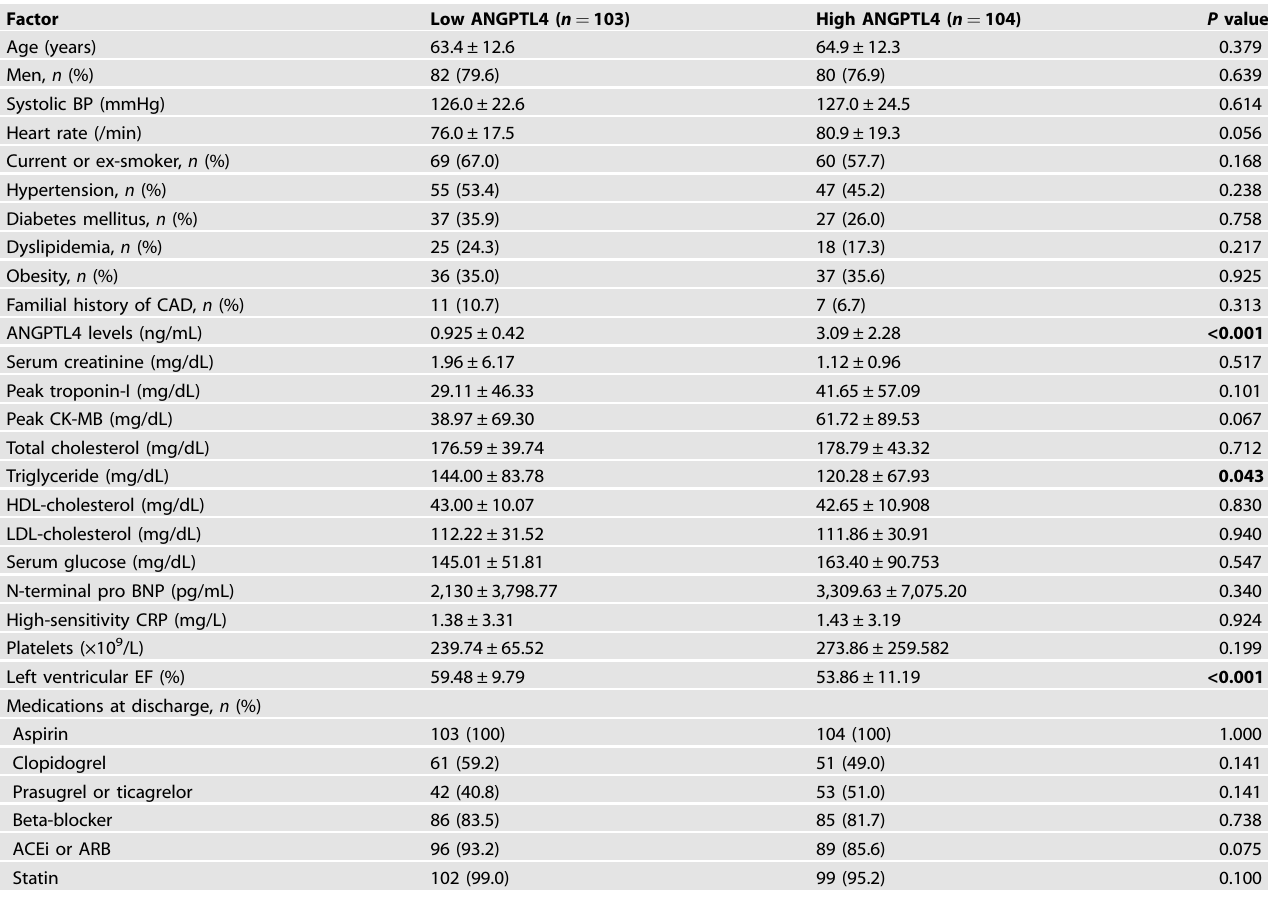
Values are presented as the mean ±SD or number (percentage). ACEi angiotensin-converting enzyme inhibitor, ARB angiotensin-II receptor blocker, BNP brain-type natriuretic peptide, BP blood pressure, CAD coronary artery disease, CK-MB creatine kinase-myocardial band isoenzyme, CRP C-reactive protein, EF ejection fraction, HDL high-density lipoprotein, LDL low-density lipoprotein. Bold values indicates statistically signi fi cant p values less than 0.05 (<0.05). patients were male in the low and high ANGPTL4 groups, respectively. In the low ANGPTL4 group, 99% of patients were prescribed statins as a discharge medication, and 40.8% of these patients were prescribed ticagrelor or prasugrel. In the high ANGPTL4 group, 95.2% of patients were prescribed a statin, and 51% were prescribed one of the newer P2Y12 inhibitors. The mean ANGPTL4 levels of the low and high ANGPTL4 groups were 0.925 ± 0.42 and 3.09 ± 2.28 ng/mL, respectively. Compared with patients with a lower level of ANGPTL4, patients with a higher level of ANGPTL4 had lower levels of triglycerides (120.28 ± 67.93 vs. 144.00 ± 83.78 mg/dL) and a lower LVEF (53.86 ± 11.19% vs. 59.48 ± 9.79%). The sex proportions and the prevalence of atherosclerotic risk factors, such as hypertension, diabetes mellitus, dyslipidemia, and familial history of coronary artery disease or smoking, were comparable between the two groups. Evidence-based medications for MI, such as antiplatelets, beta- blockers, renin-angiotensin-aldosterone system blockers, and statins, were also similarly prescribed to patients in both groups. Given that normal triglyceride levels are less than 150 mg/mL, the average range of triglycerides in this study was not considered pathological. Reduced TG levels may be a secondary effect of the bene fi cial changes related to ANGPTL4.